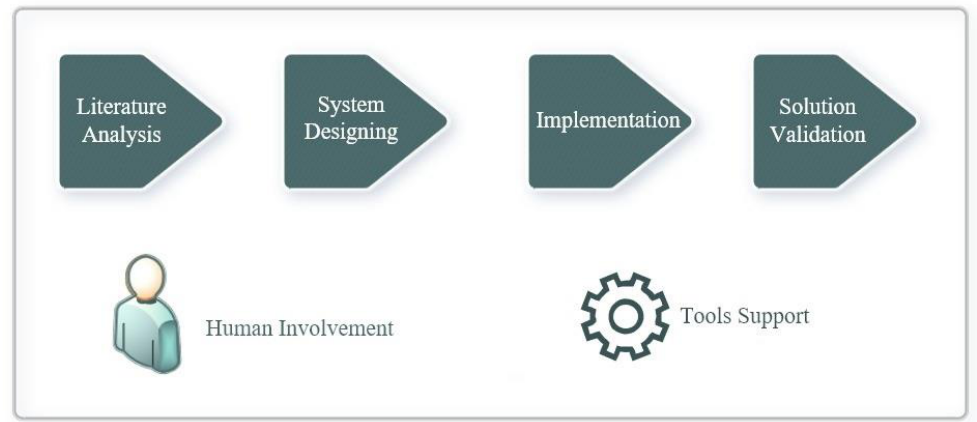
Figure 1. Overview of Research Methodology.